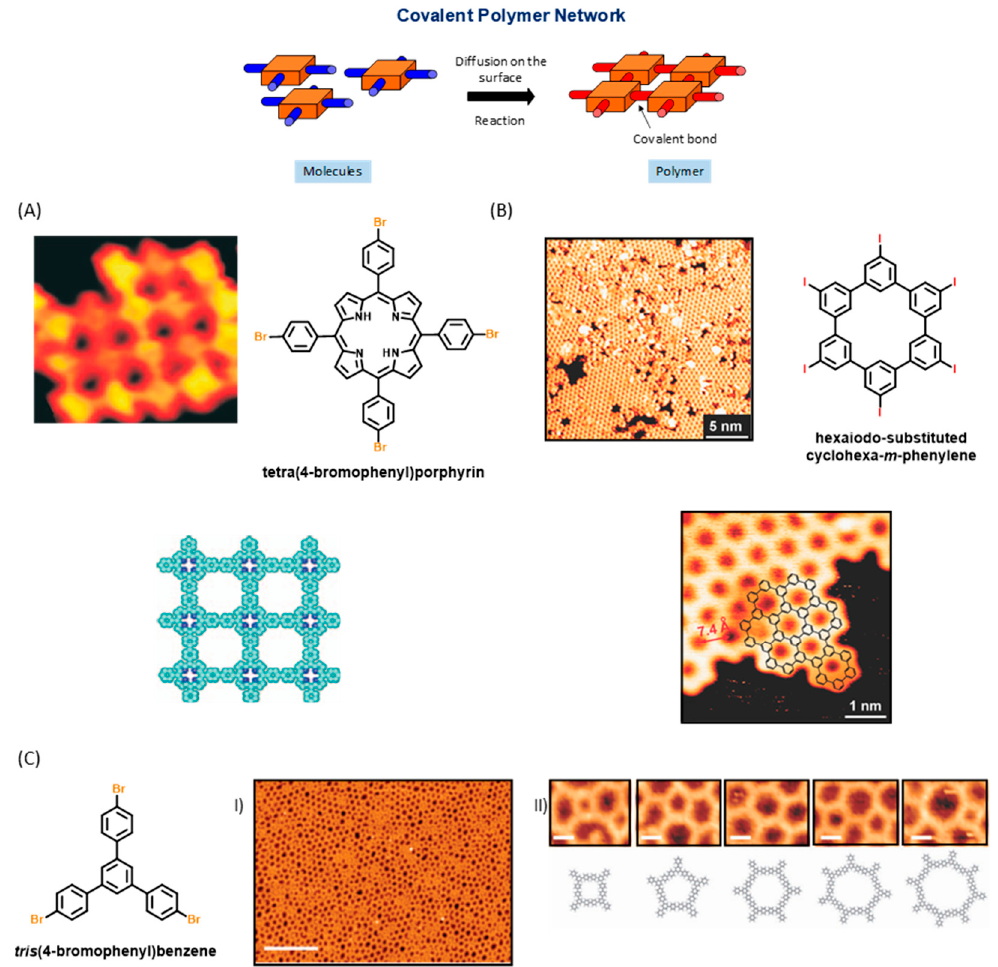
Figure 2. Principles of the formation of covalent polymer network on surface. ( A ) STM image of the polymerization of tetra(4-bromophenyl)porphyrin on Au(111). Reprinted by permission from Springer Customer Service Center GmbH: Springer Nature, Nature Nanotechnology, Grill et al. [18], 2007. ( B ) STM image of the polymer formed with hexaiodo-substituted cyclohexa- m -phenylene on Ag(111). Reproduced from [19] with permission from The Royal Society of Chemistry. ( 3 ) STM image of the polymer formed with tris (4-bromophenyl)benzene on Au(111). Scale bars: (I) 190 Å, ( II ) 14 Å. Adapted from [20] with permission from The Royal Society of Chemistry